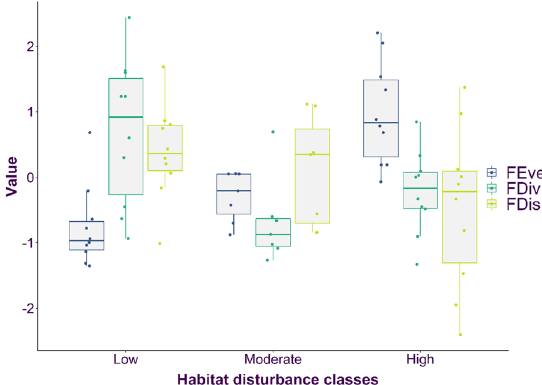
Fig. 9 Boxplot comparing functional evenness (FEve), functional divergence (FDiv), and functional dispersion (FDis) of spider community between the lowly, moderately, and highly disturbed 17.392, sites along the Ganga River, India (for FEve Kruskal–Wallis χ 2 = df 2, p < 0.05; for FDiv Kruskal–Wallis χ 2 8.154, df 2, p < 0.05; for = = = FDis Kruskal–Wallis χ 2 2.840, df 2, p > 0.05). Each box represents = = the 25%/75% quartiles, and the median is shown with a